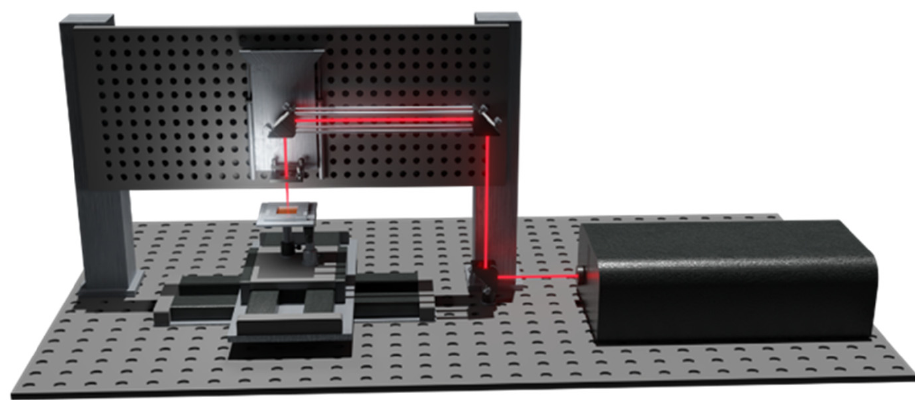
Figure 1. Sketch of the laser-based microfabrication setup. The laser source was carried and focalized over the sample, stuck on the translational stage.